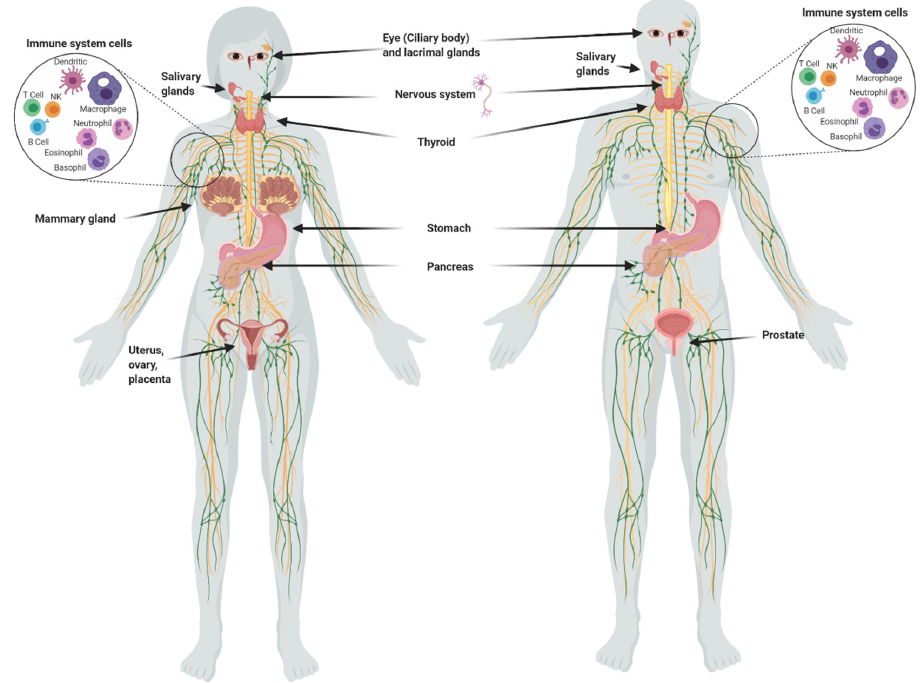
Figure 1. Organs and tissues that take up